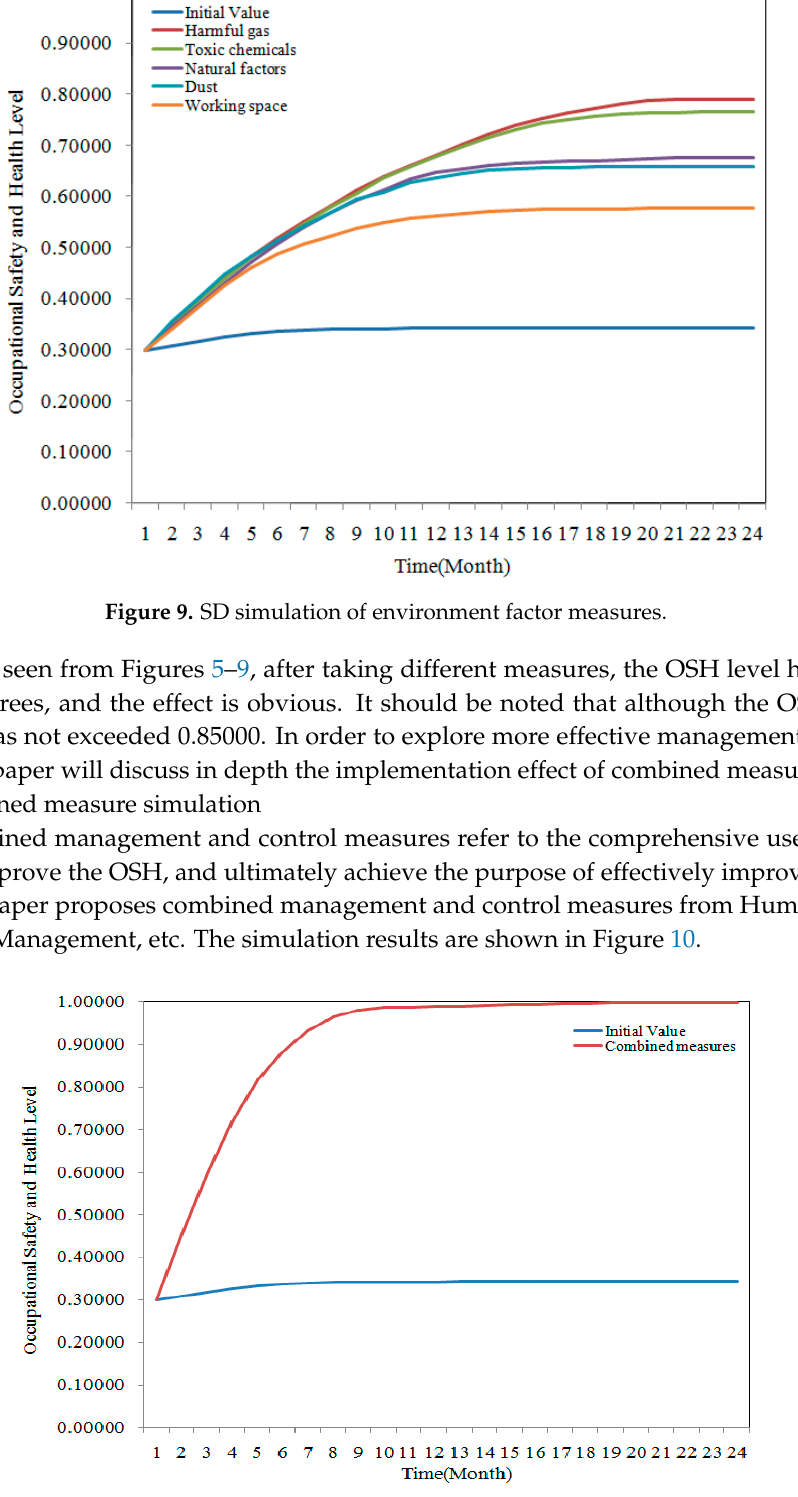
Figure 10 . SD simulation of combined measures. Figure 10. SD simulation of combined